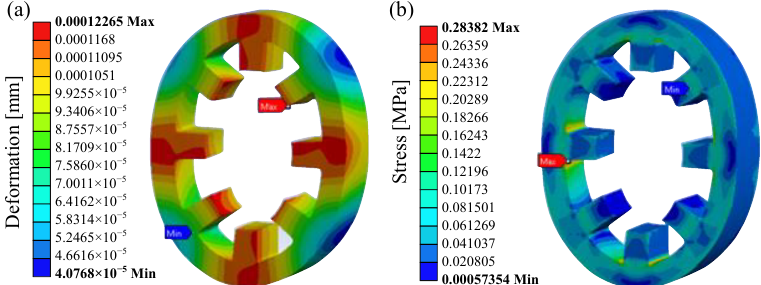
Figure 12. Mode shapes for the dominant vibration mode 2 of the baseline 8/6 SRM stator.